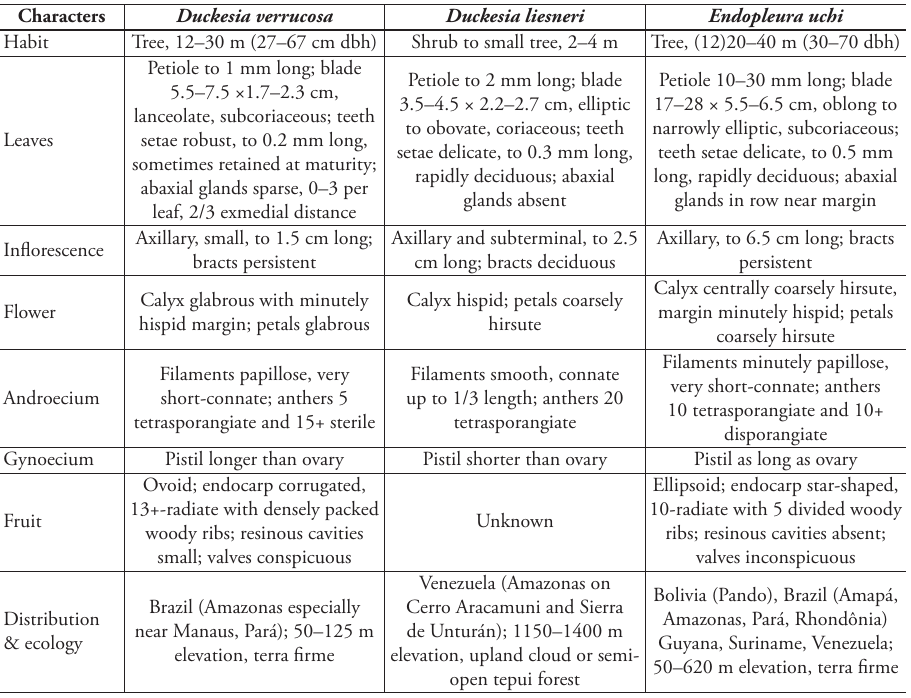
Table 1. Comparison of select diagnostic features for Duckesia and Endopleura